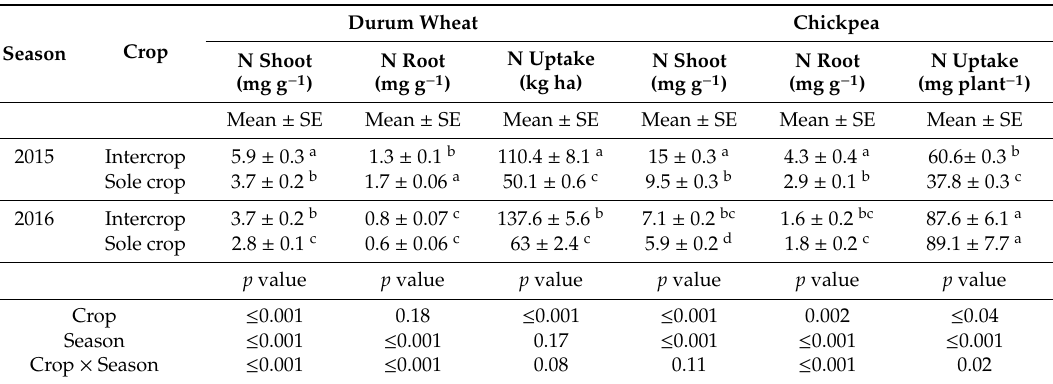
Table 1. Nitrogen concentration in shoots and roots and N uptake for whole plants for chickpea and durum wheat. Values represent the average of 10 replicates ± SE (standard errors). p -values from ANOVA (Cropping system, season, and cropping system × season).